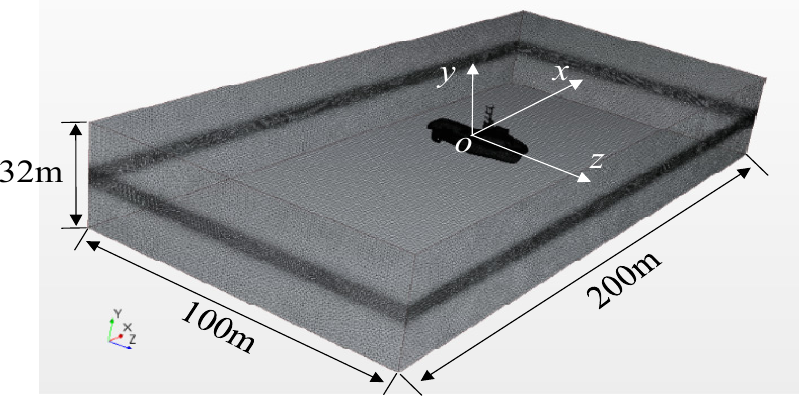
Figure 4. Mesh of computational domain. simulation. The impact of ship speed was not considered for the time being; only the forward speed.